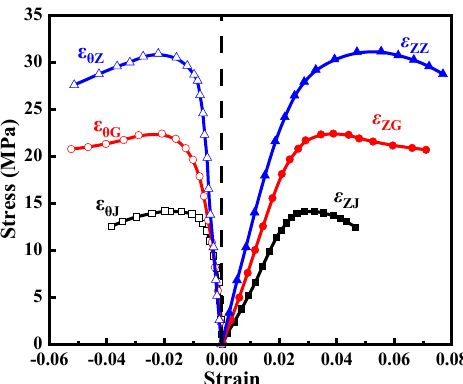
Figure 2. Stress-strain curves of coal samples: ε ZJ , ε ZG and ε ZZ are axial strain of JLS, GHS and ZG, respectively; ε θJ , ε θG and ε θZ are radial strain of JLS, GHS and ZG, respectively.